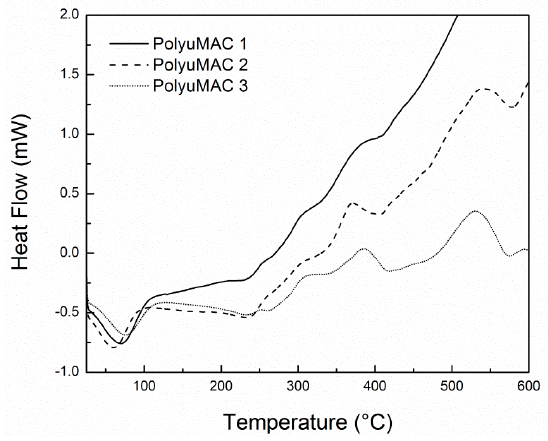
Figure 4. DSC results from the polyimide foam.